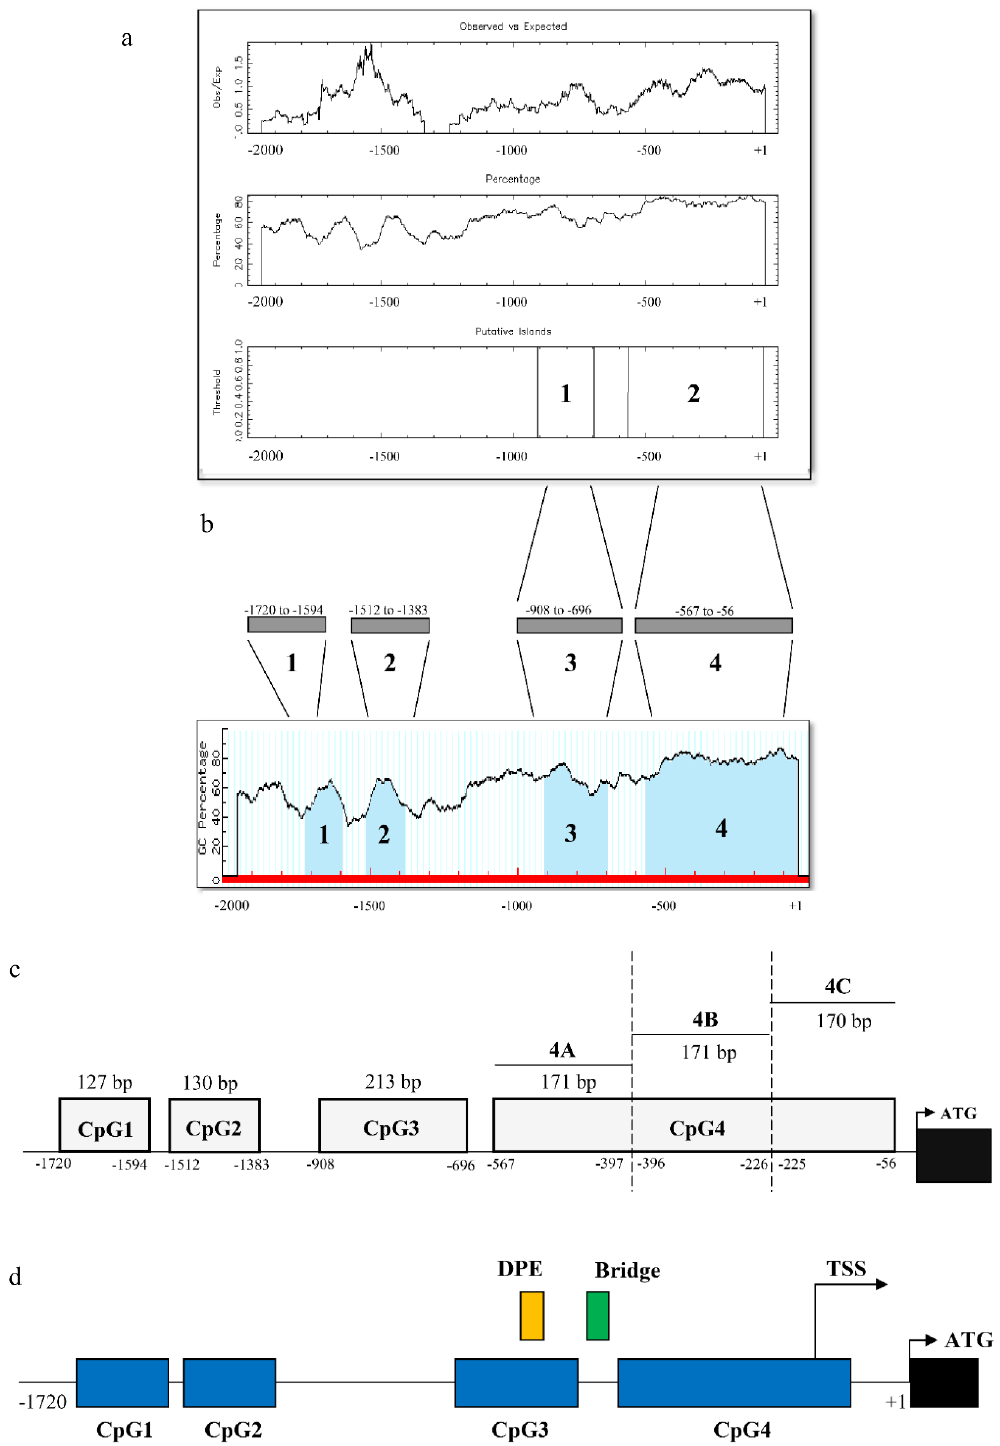
Figure 1. Identification of CpG islands of ck α promoter using: ( a ) MethPrimer and ( b ) EMBOSS CpGPlot; ( c ) CpG4 was divided into three smaller fragments which are CpG4A, CpG4B, and CpG4C and ( d ) the regulatory elements predicted in cka gene promoter. The blue boxes indicate the CpG islands. The yellow and green boxes indicate the downstream promoter element (DPE) and Bridge element, respectively. The transcription start site (TSS) was identified from DBTSS and ATG start codon are shown in bold uppercase letters. Black box indicates the first